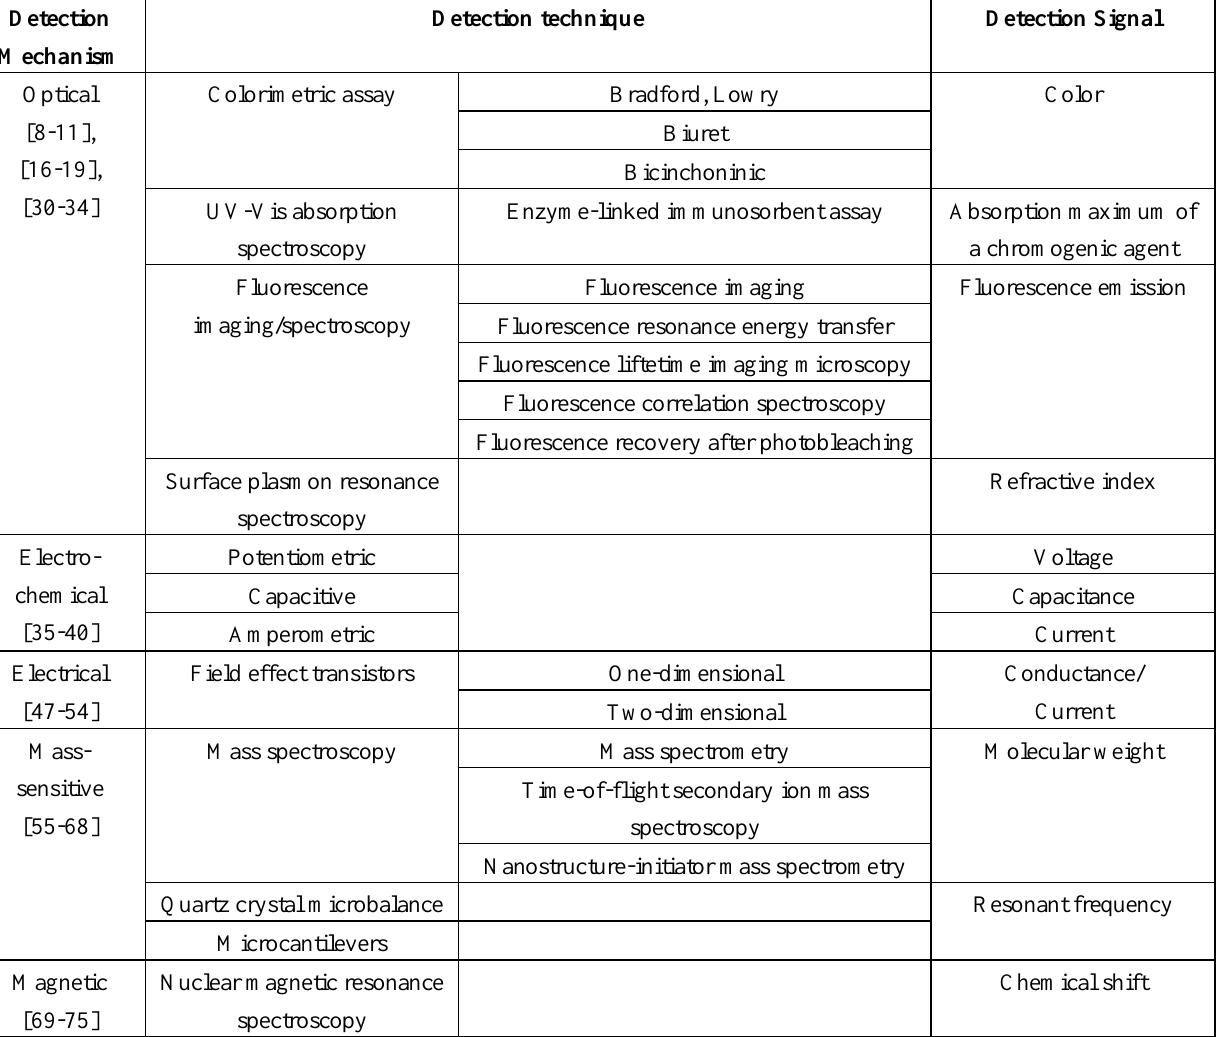
Table 1. Various protein detection sensors involving polymers; optical, electrochemical, electrical, mass-sensitive, and magnetic